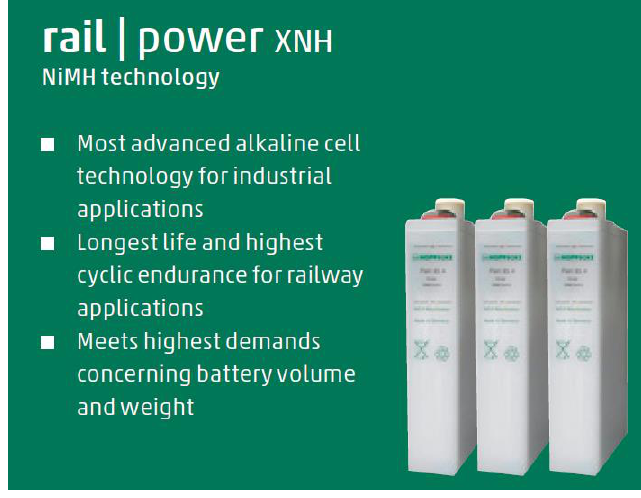
Figure 9. Prismatic flooded Ni/MH batteries from Hoppecke [97].